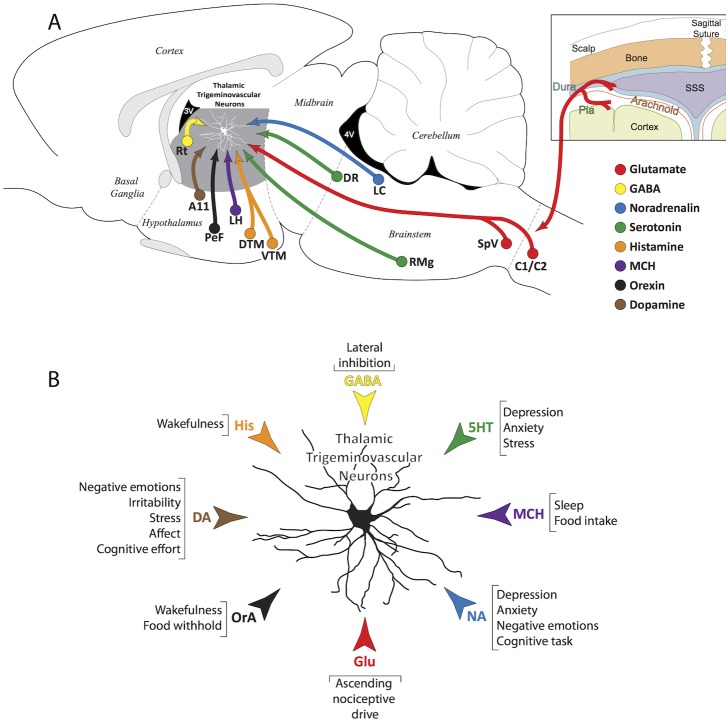
(A) Schematic illustration of the neurotransmitter and neuropeptidergic systems innervating thalamic trigeminovascular neurons in VPM, Po and LP/LD.The peripheral (meningeal nociceptors) and central (trigemino-thalamic) components of the trigeminovascular pathway are shown in red. The neurotransmitter and neuropeptidergic systems are color coded as follow: (a) Glutamate from SpVC/C1-2 in red; (b) GABA from Rt in yellow; (c) Noradrenalin from LC in blue; (d) Serotonin from raphe magnus (RMg) and dorsal raphe (DR) in green; (e) Histamine from DTM and VTM in orange; (f) Melanin Concentrating Hormone from LH in purple; (g) Orexin from PeF in black; (h) Dopamine from A11 in brown. (B) The diverse neurochemical pathways that converge on thalamic trigeminovascular neurons and the probability that many of them modulate neuronal activity in the same direction under certain conditions (e.g., sleep deprivation, wakefulness, food withhold, stress, anxiety) and in opposite directions under other conditions (e.g., food intake, sleep) define a sophisticated neuroanatomical network that may help us conceptualize how sensory, physiological, cognitive and affective conditions trigger, worsen or improve migraine headache.